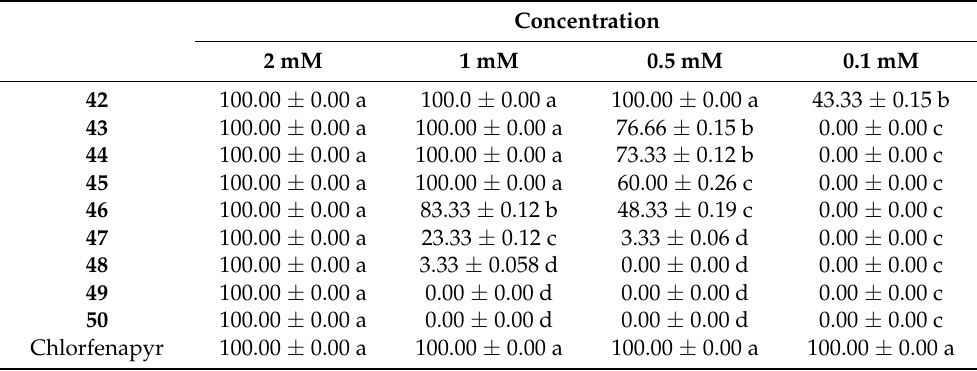
Table 1. Mortality percentage of P. xylostella larvae after 24 h of exposure to the diet containing the conjugates 42 – 50